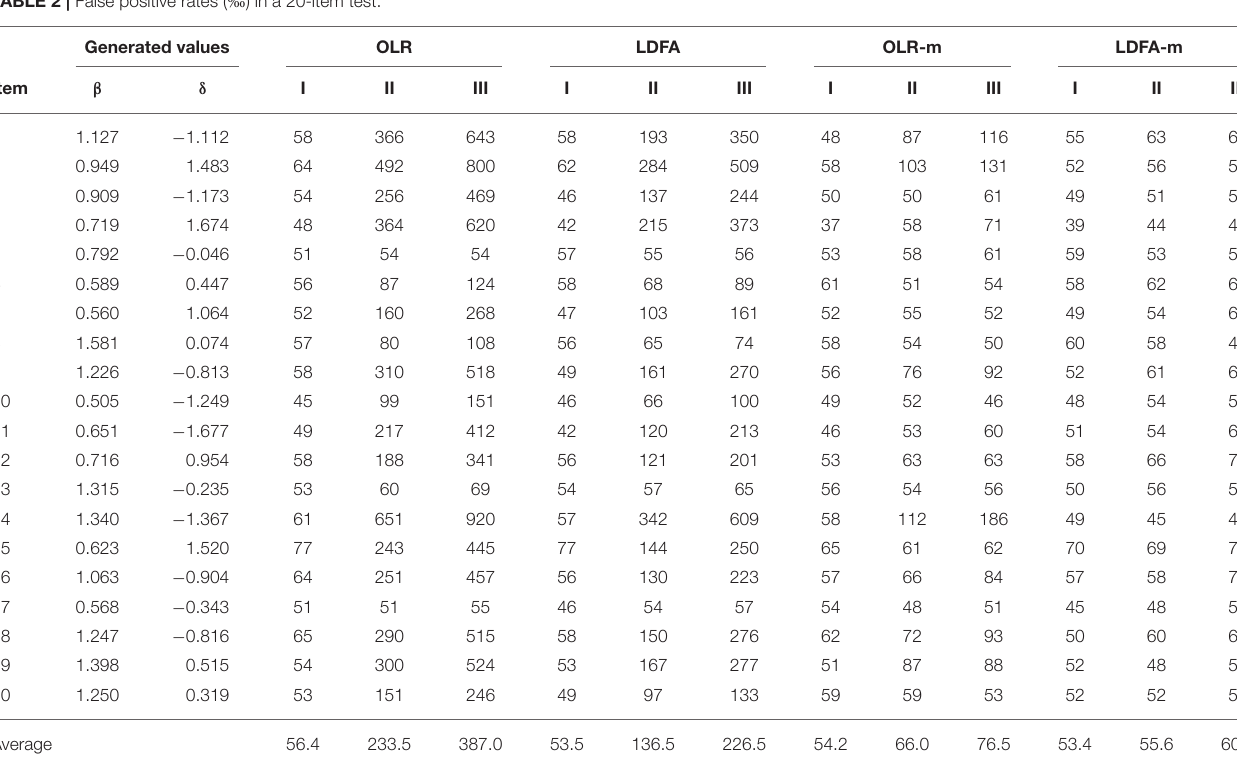
TABLE 2 | False positive rates ( ‰ ) in a 20-item test. Generated